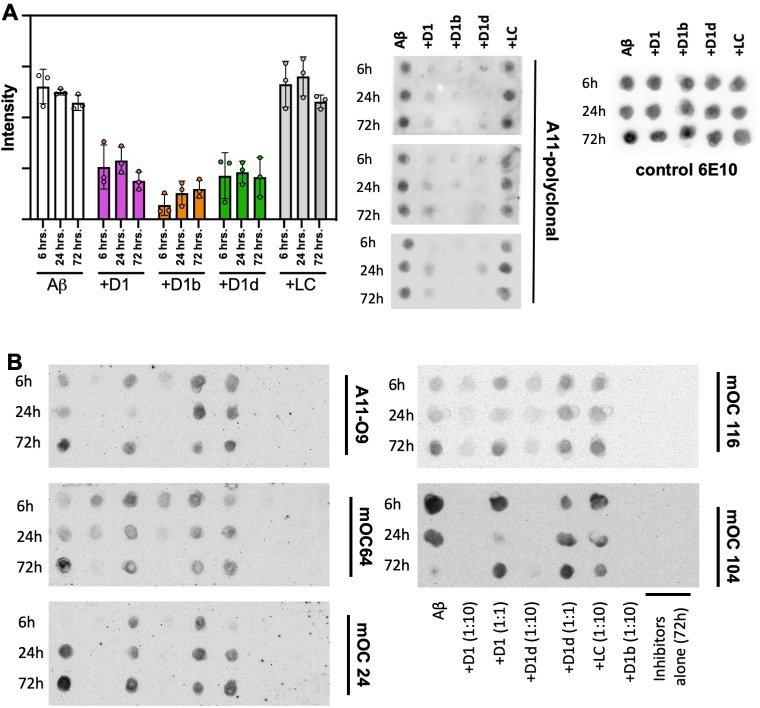
Extended dot blot data.(A) Peptide inhibitors reduce the formation of oligomeric Aβ1–42 recognized by polyclonal A11 antibody, while negative control peptide does not. 10 μM Aβ1–42 was incubated alone (left-most column) or with 10-fold molar excess of each peptide-based inhibitor. Aliquots of the reaction were tested for antibody-binding at 6 hr, 24 hr, and 72 hr. 6E10 anti-amyloid beta (Tanzi, 2012; Hardy and Selkoe, 2002; Manczak and Reddy, 2014; Seward et al., 2013; Brier et al., 2016; Schwarz et al., 2016) was used as a loading control. Blots were quantified using ImageJ. (B) Unspliced dot blots from Figure 4C. Column key displayed at lower right is representative of all displayed blots in B.